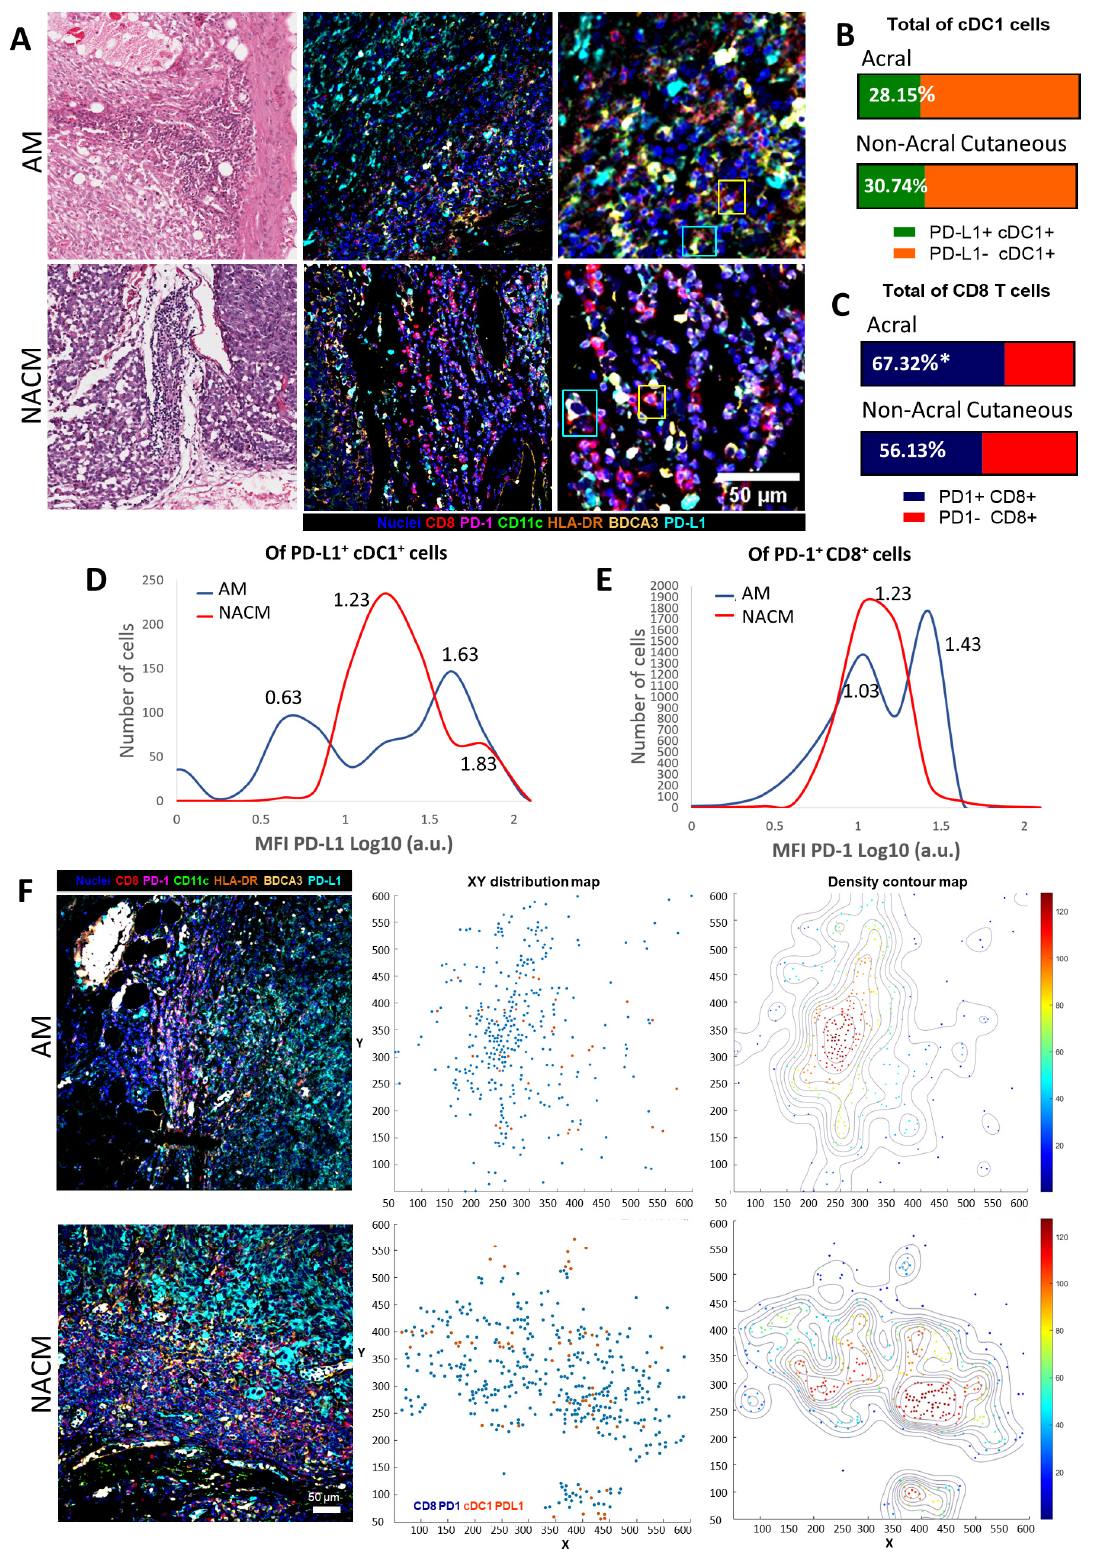
Figure 5. Acral melanoma is infiltrated by PD-1 + CD8 T cells and PD-L1 + cDC1s. ( A ) Representa- tive hematoxylin & eosin (left) and multiparametric immunofluorescence (mIF) images (middle and right (zoomed of a highly infiltrated area)) of advanced acral melanoma (AM) and